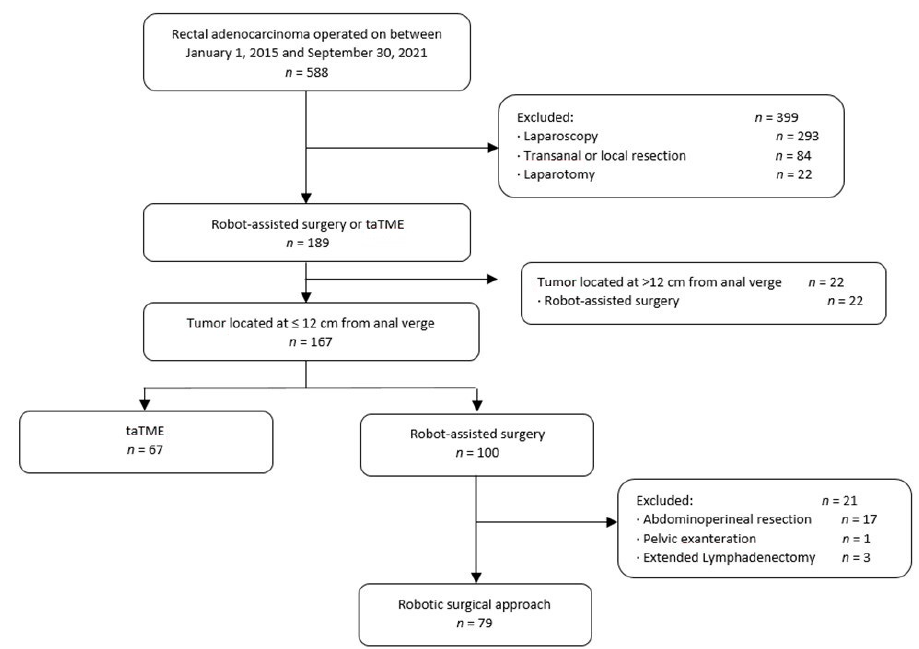
Figure 1. Flowchart of the study.